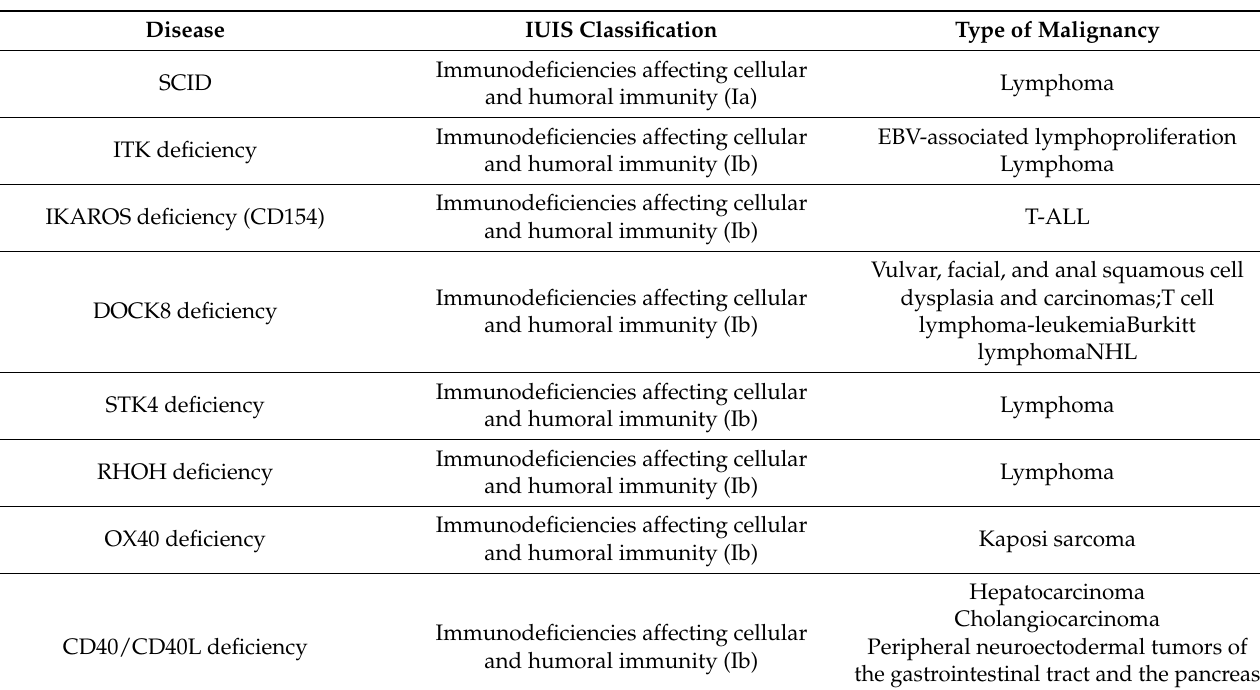
Table 3. Most common types of cancer among patients with